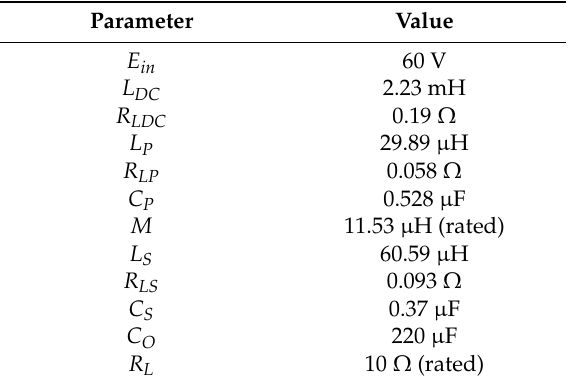
Table 1. Parameters of the experimental system.